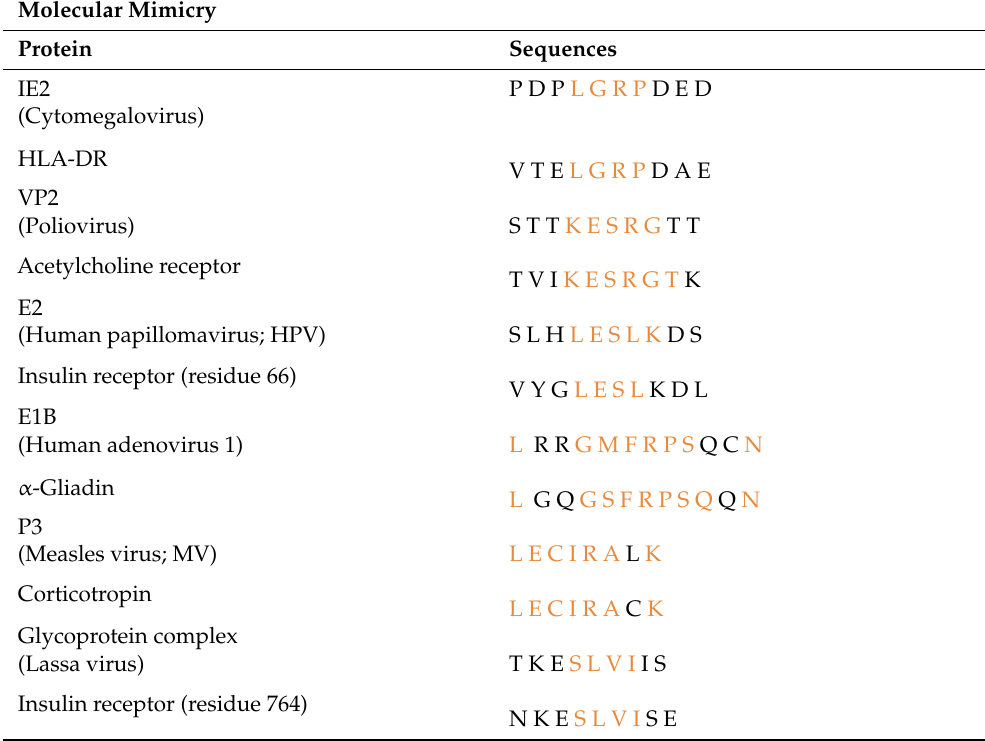
Table 1. Examples of molecular mimicry between micro-organisms and human proteins